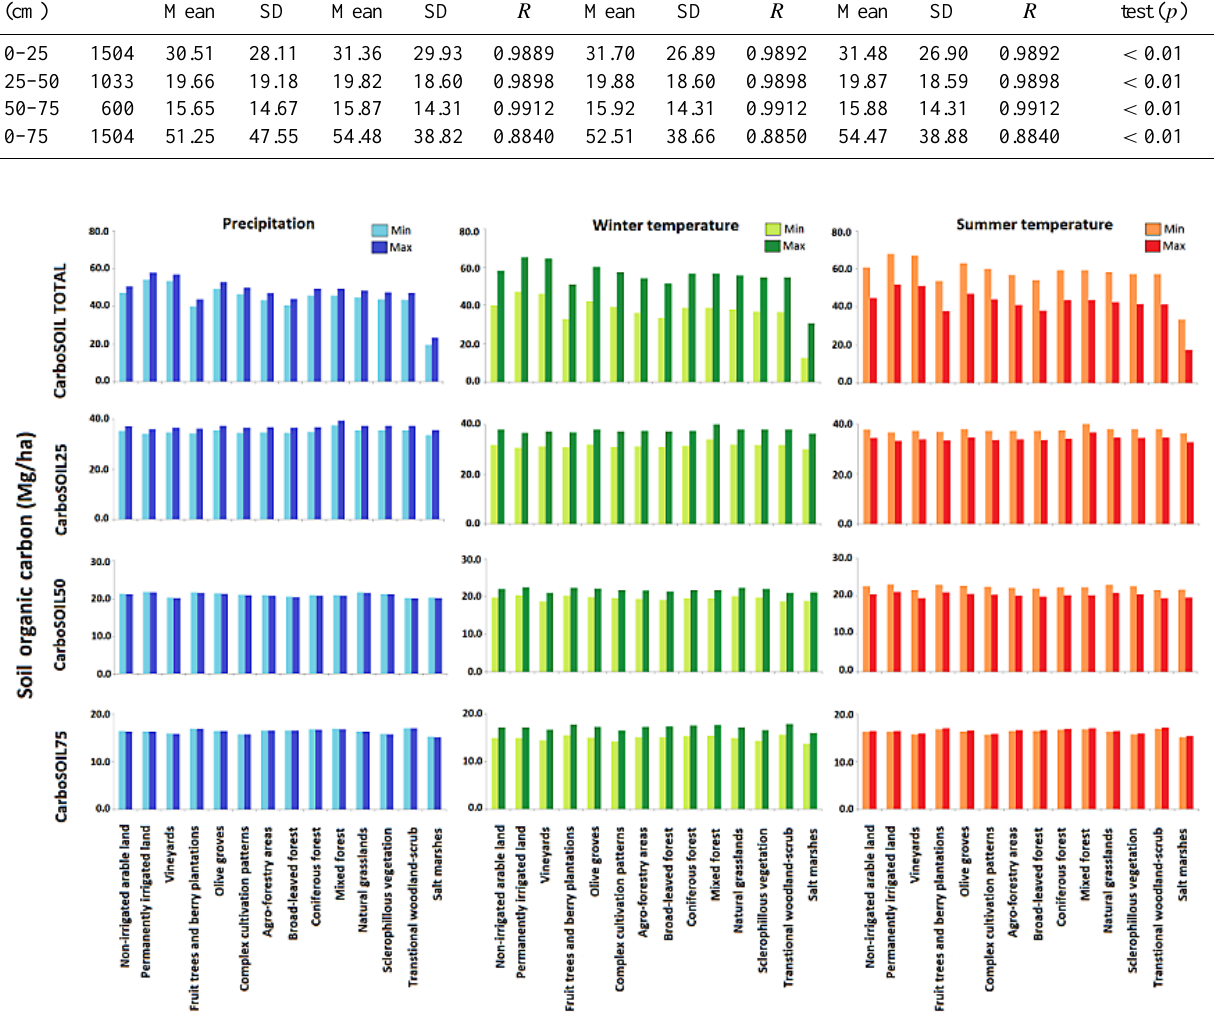
Fig. 3. CarboSOIL model evaluation for climate variables (annual precipitation, mean winter temperature and mean summer temperature) at different soil depths: 0–25 (CarboSOIL25), 25–50 (CarboSOIL50), 50–75 (CarboSOIL75) and 0–75cm